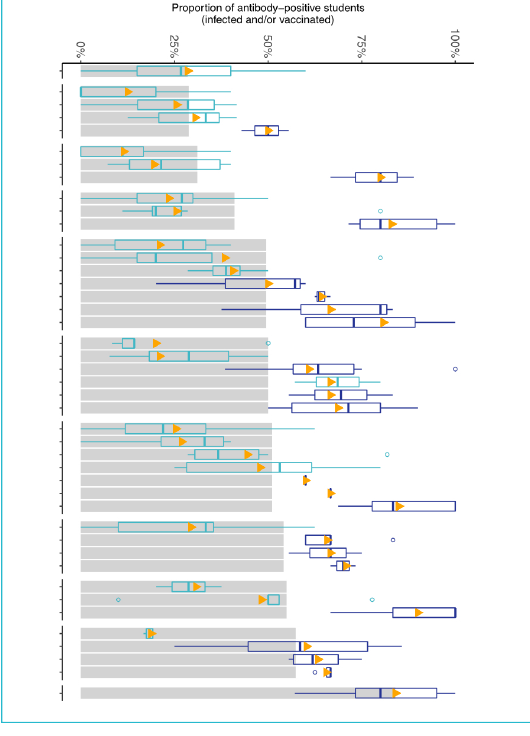
Figure 2: Variability of seroprevalence of children and adolescents at T4 (November–December 2021) among 11 districts (grey bars, mean), 43 schools (triangles, mean) and 200 classes (boxplots) within the same schools and districts. Along the horizontal axis, schools are displayed without names for reasons of confidentiality. Only classes where more than five children participated were in- cluded. Boxplots describe variability of seroprevalence on a school level, with middle bar indicating median seroprevalence, box rep- resenting the interquartile range (middle 50% of classes) and whiskers the more extreme classes.